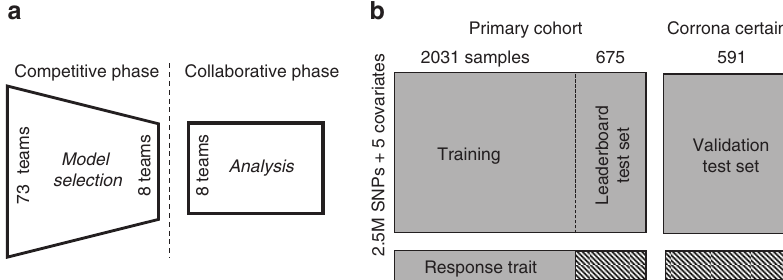
Figure 1 | Challenge schematic. ( a ) This analysis was performed in two phases. In the Competitive phase, an open competition was performed to formally evaluate and identify the best models in the world to address this research question. In all, 73 teams representing 242 registered participants joined the challenge. Organizers evaluated model performance for test set predictions submitted by 17 teams. The 8 best-performing teams were invited to join the collaborative phase. In this phase, a collectively designed experiment was developed, in which each team independently performed analyses and challenge organizers performed a combined analysis. ( b ) Two data sets were used in the analysis: the Discovery cohort and the CORRONA CERTAIN study. Participants were provided with 2.5M imputed SNP genotypes þ 5 covariates from two cohorts and with the response trait for 2,031 individuals in the Discovery cohort (‘Training Set’). At the completion of the 16-week training period, participants were required to submit a final submission containing predictions of response traits in a completely independent data set, the CORRONA CERTAIN study (‘Validation Test